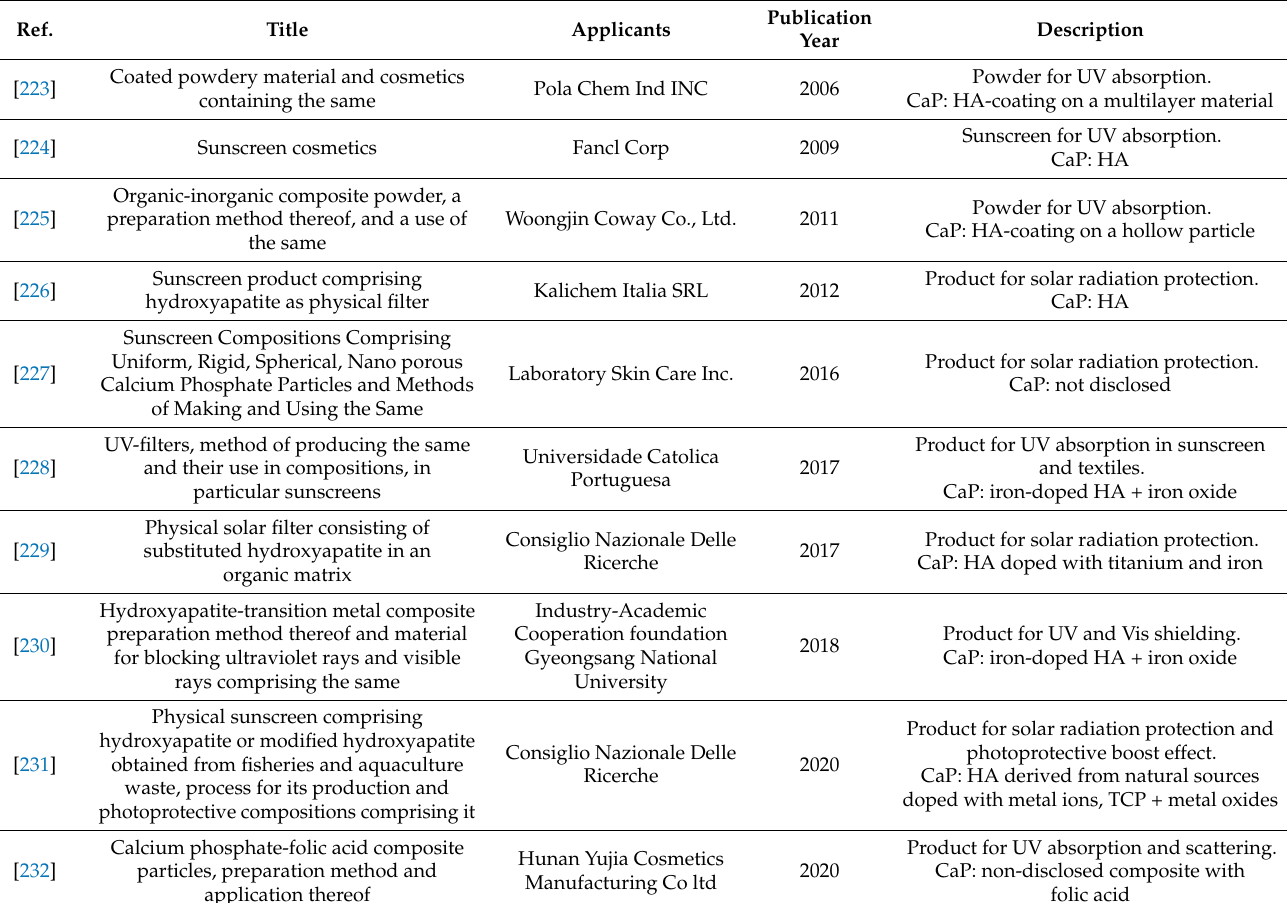
Table 3. List of patents about calcium phosphates as